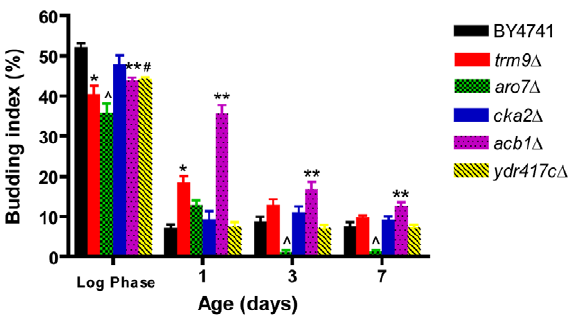
Figure 8. Efficiency of G1/G0-arrest of the novel long-lived mutants. Budding index of BY4741 and mutants lacking either Acb1, Cka2, Trm9, Ydr417c, or Aro7 measured during exponential growth (OD 600 =1) and chronological aging on day 1, 3, and 7. Data show mean 6 SEM. * p , 0.01, trm9 D vs WT. **p , 0.05, p , 0.001, p , 0.01, acb1 D vs WT in exponential phase, on day 1, and on day 3–7, respectively. ‘ p , 0.001, p , 0.01, aro7 D vs WT, in exponential phase, day 7, and on day 3, respectively. # p , 0.05, ydr417c D vs WT. The cultures used were incubated in SDC medium for the duration of the whole